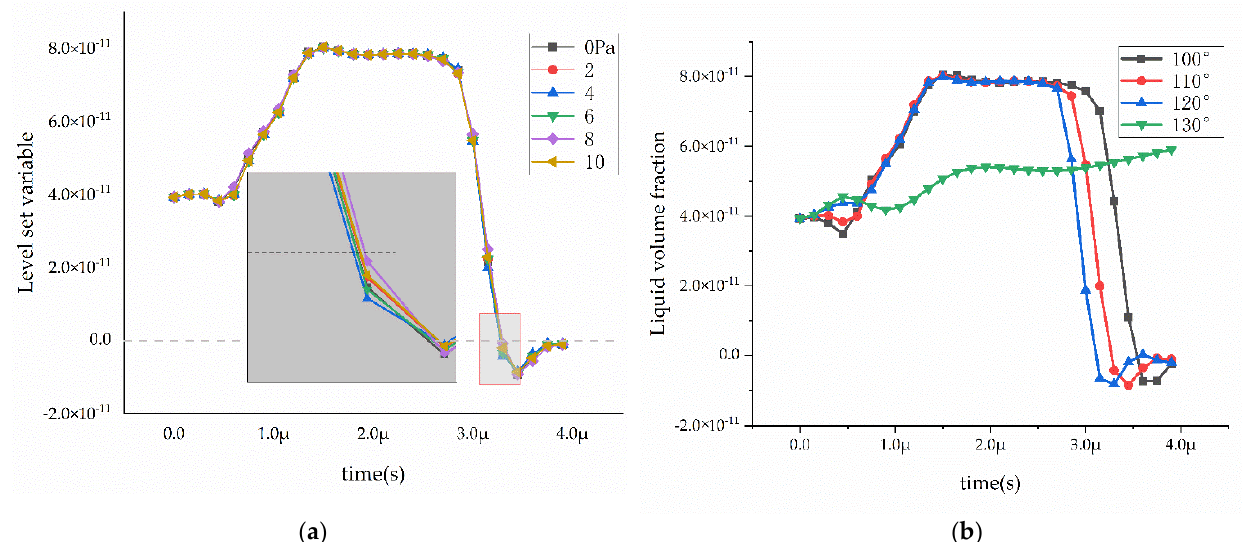
Figure 9. Changes of the horizontal variables and the integral value of the liquid volume fraction on the lower boundary line of domain 2. Represented in ( a ) is the level set variable with an aperture of 5 μ m, the contact angle is 100°, and the pressure is 0–10 Pa. Represented in ( b ) is the level set variable with an aperture of 5 μ m, the contact angle is 100–130°, and the pressure is 4 Pa.